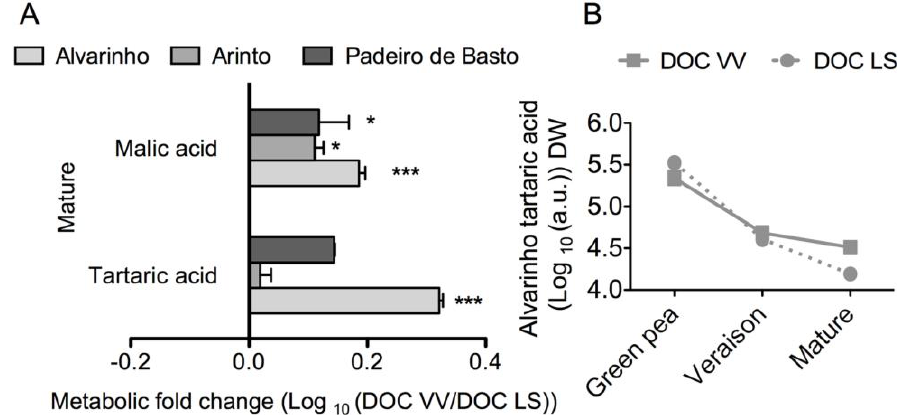
Figure 4. Key organic acids in grape berries from Alvarinho, Arinto and Padeiro de Basto cultivated in the DOC VV and DOC LS regions. The levels of tartaric acid and malic acid at the mature stage are the logarithmic transformed fold change (DOC VV/DOC LS) of berries from Alvarinho, Arinto and Padeiro de Basto ( A ); Logarithmic tartaric acid levels of Alvarinho during grape berry development and ripening ( B ). Columns represent the means ± SE ( n = 3); asterisks denote the significance levels comparing DOC VV to